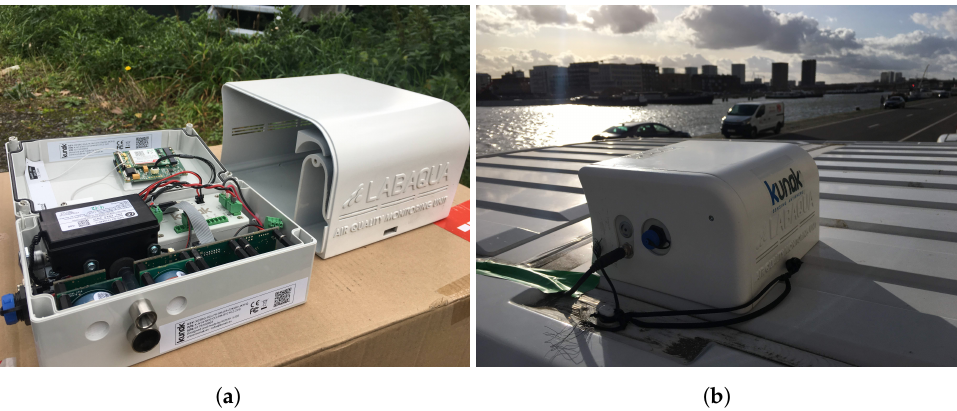
Figure 2. The Kunak AIR mobile sensor system used in this paper. ( a ) A Kunak sensor box contains three types of Alphasense sensors for measuring the concentration of PM 1 , PM 2.5 , PM 10 (OPC-N3), NO 2 (NO2-B43F) and O 3 (OX-B431), in-built sensors for measuring environmental temperature and relative humidity, as well as a GPS device. ( b ) The Kunak sensor box with a mobile housing is mounted on the roof of a postal van.